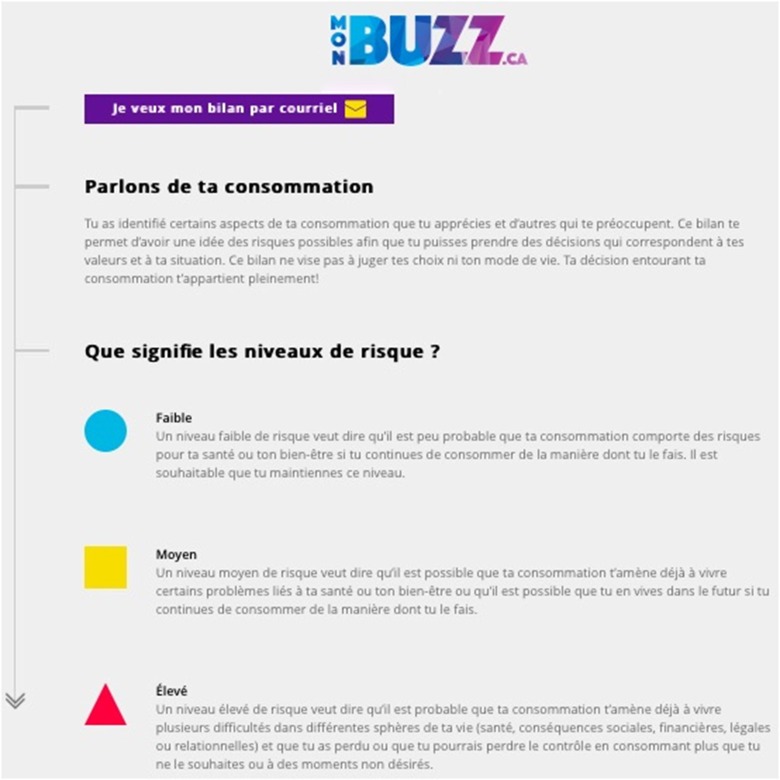
Example of feedback.